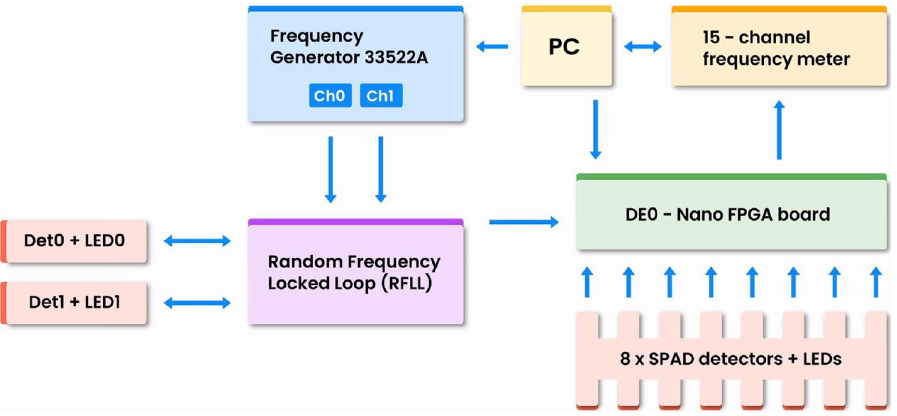
Figure 2. Setup for experimental implementation and testing of RPC circuits.